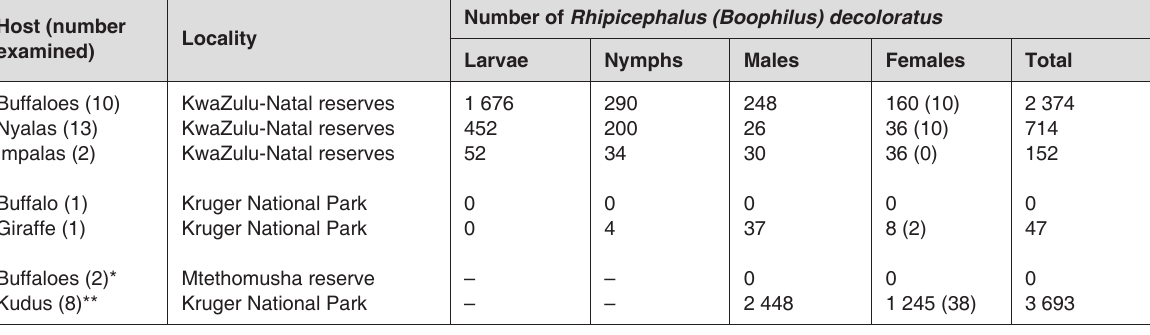
TABLE 3 Total numbers of Rhipicephalus (Boophilus) decoloratus collected from African buffaloes and antelopes examined during the same time of year at the same or adjacent localities